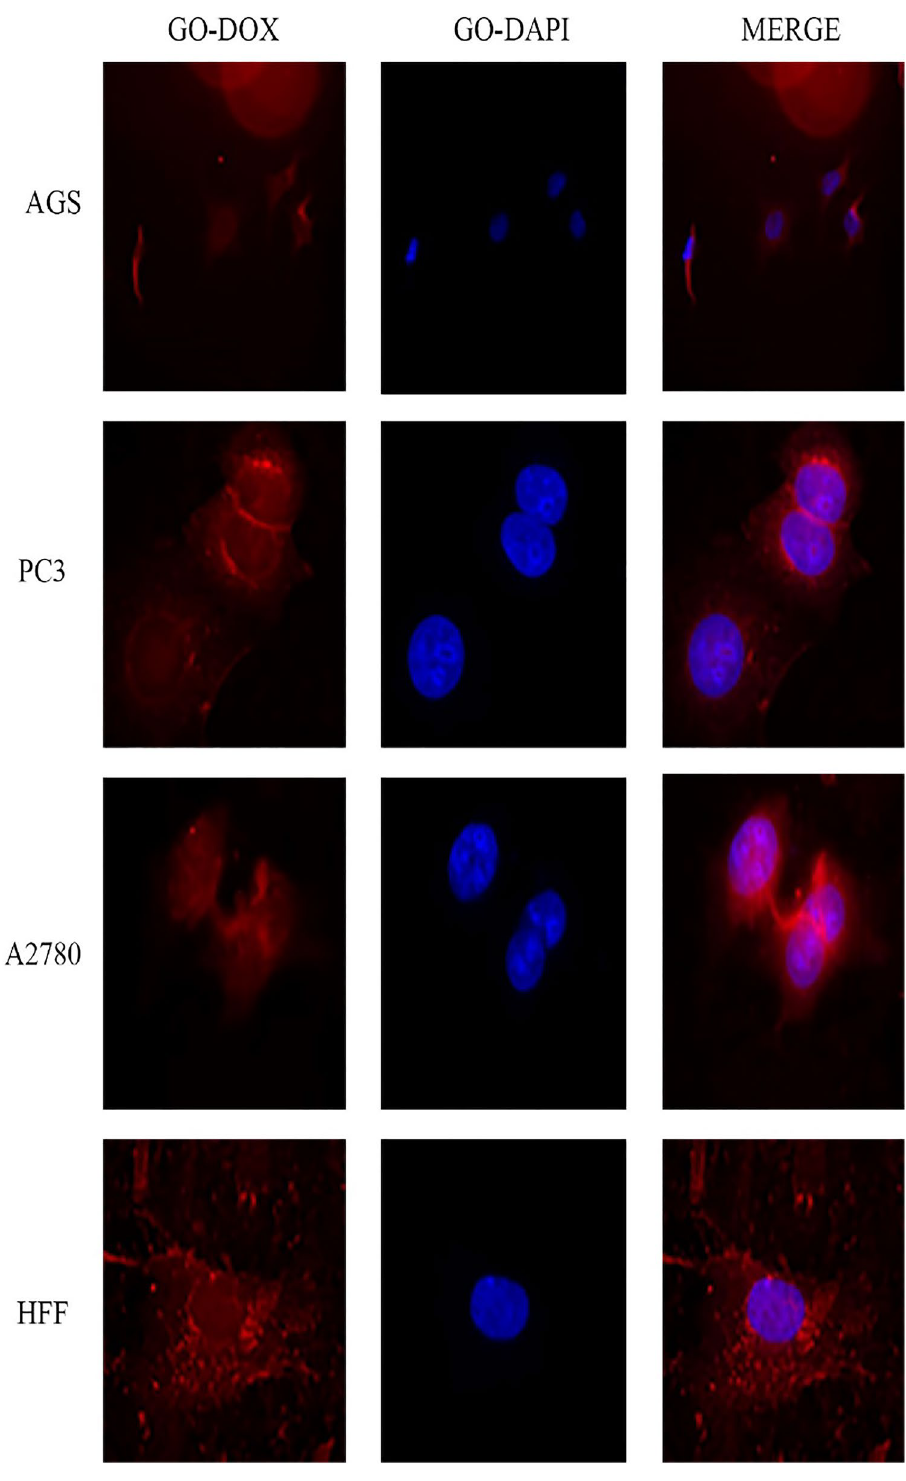
Figure 8. Cellular uptake images of AGS, PC3, A2780 and HFF cells incubated with GO-DOX for 180